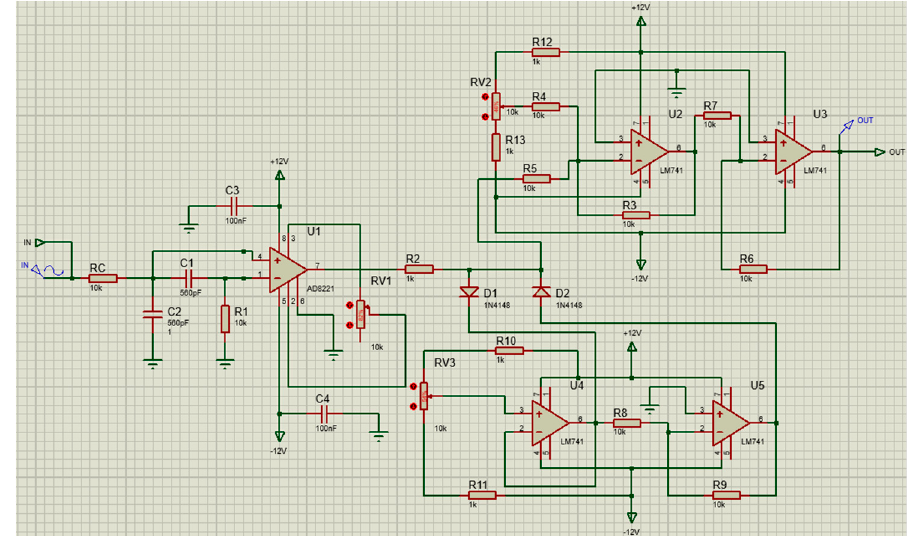
Figure 6. Simulation of the analog part (without the accelerometer and the signal conditioner) in Proteus.